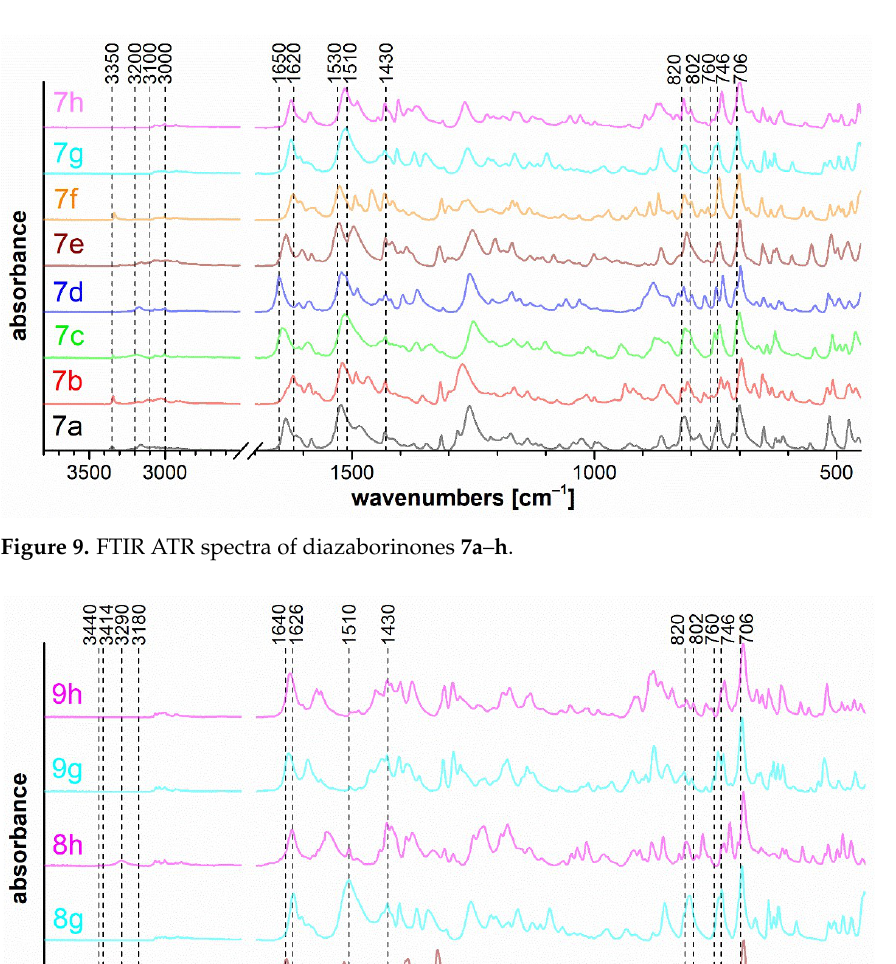
Figure 8. FTIR ATR spectra of oxazaborines 6a, 6e – h .